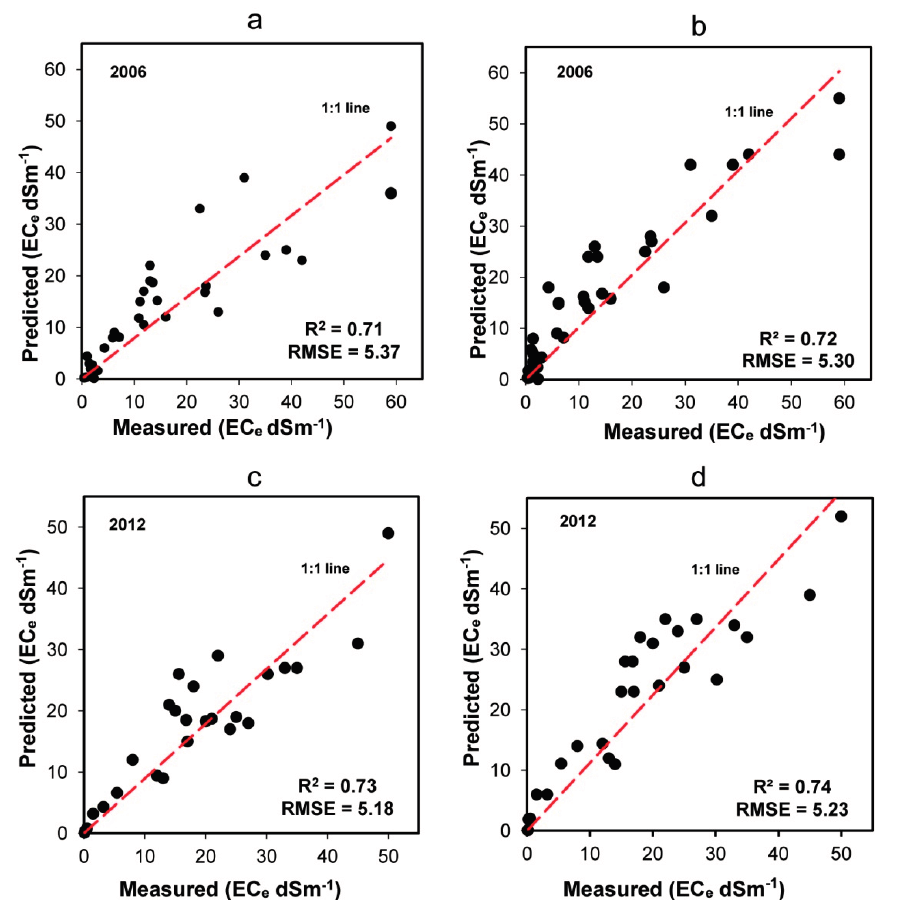
Figure 8. Scatterplots of measured versus extracted EC e values for ( a ) PLSR results for 2006; ( b ) MARS results for 2006; ( c ) PLSR results for 2012; and ( d ) MARS results for